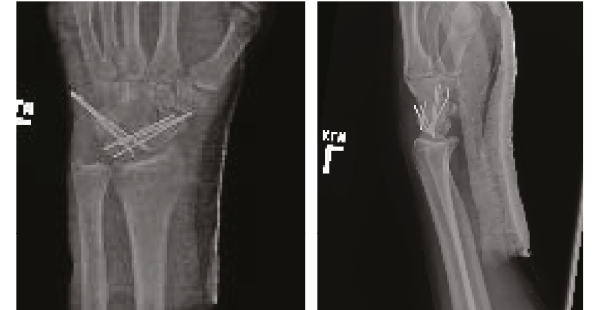
Figure 1: Presenting plain fi lms demonstrating volar scaphoid dislocation.